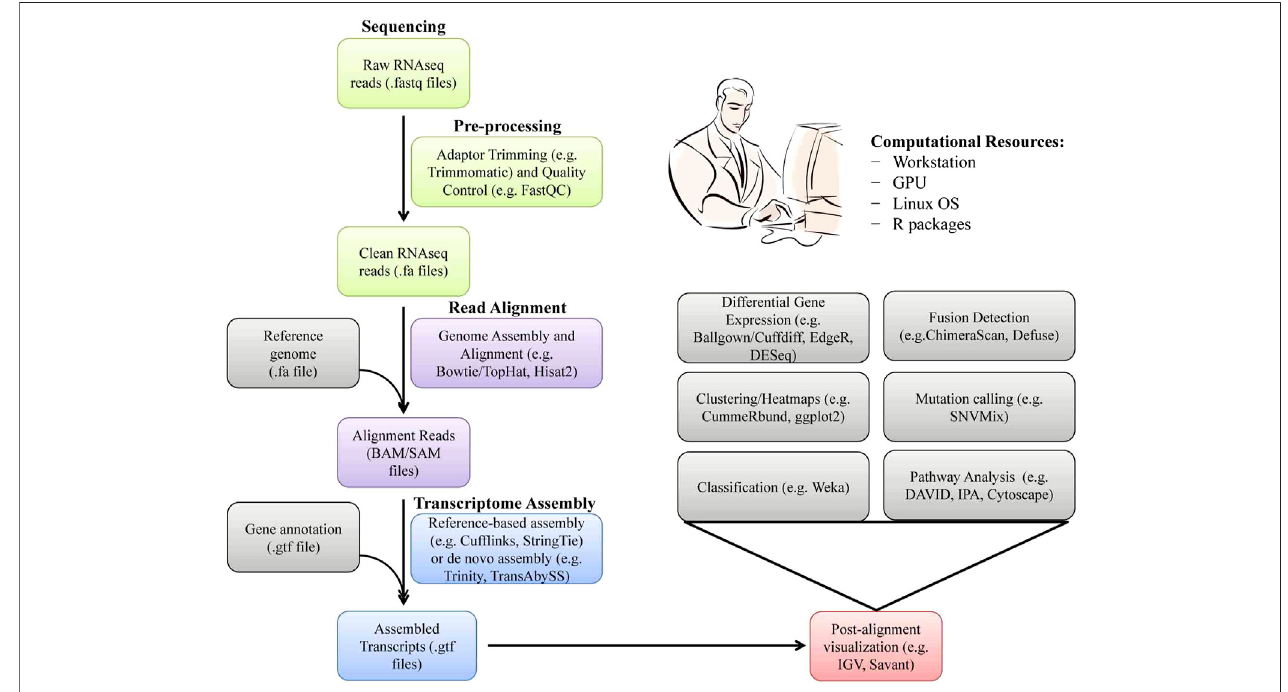
FIGURE2| AsoftwarepipelineandcomputationalresourcesusedforanalysisofRNAseqdata.EachtypeofRNAseqhasdistinctrequirementsandchallengesbut there is a common work fl ow/pipeline.